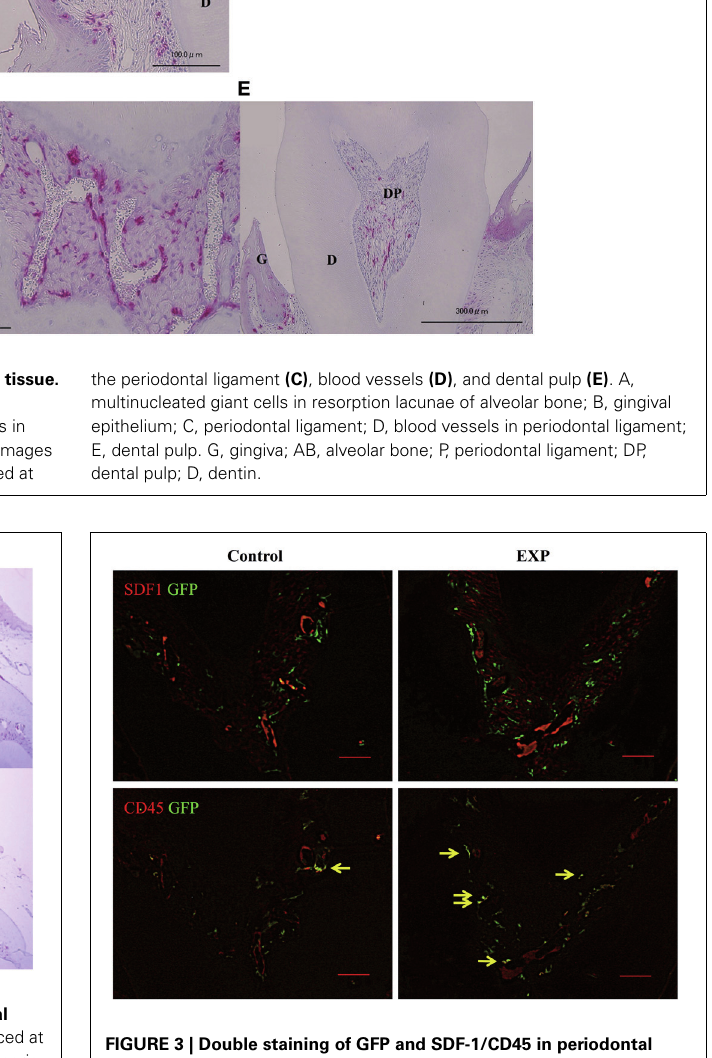
FIGURE 3 | Double staining of GFP and SDF-1/CD45 in periodontal ligaments. In control sites, blood vessel-like structures showed intense staining of SDF-1. GFP-positive cells were observed around SDF-1-positive cells. In experimental sites, SDF-1 expression was ubiquitously detected in periodontal ligament 5 weeks after surgery. The number of GFP-positive cells in experimental tissues was higher than in controls. In experimental tissue, the number of GFP( + )/CD45( + ) cells (yellow arrows) was elevated, accounting for 13% of GFP-positive cells ( n = 4). injury, some SDF-1 was observed within the blood vessels of periodontal ligaments in control tissue. In experimental tis- sue, weak and diffuse SDF-1 staining was observed in the defects and periodontal ligament. After 2 weeks, SDF-1 stain- ing increased markedly and was attenuated by 4 weeks after